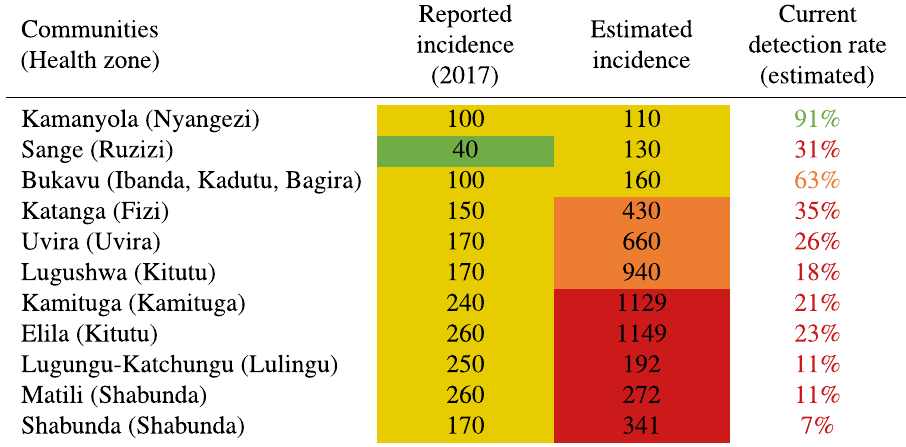
Table 2. Distribution of reported and estimated incidence on the communities interested in this work.